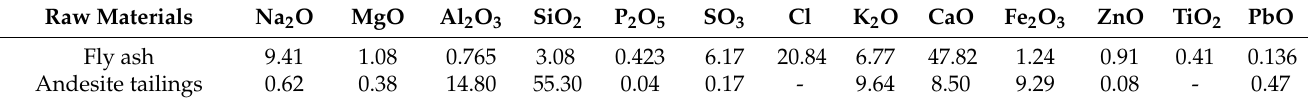
Table 1. Major chemical composition of raw materials (wt%).